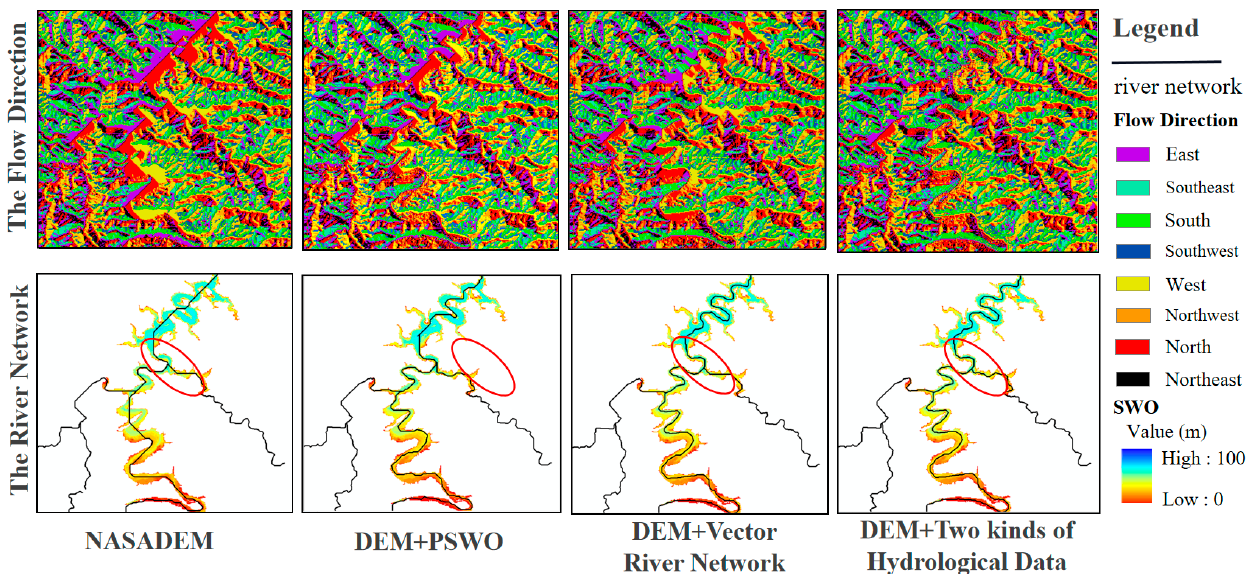
Figure 10. Comparison maps of different reconstructed DEM (significant changes are marked in red).